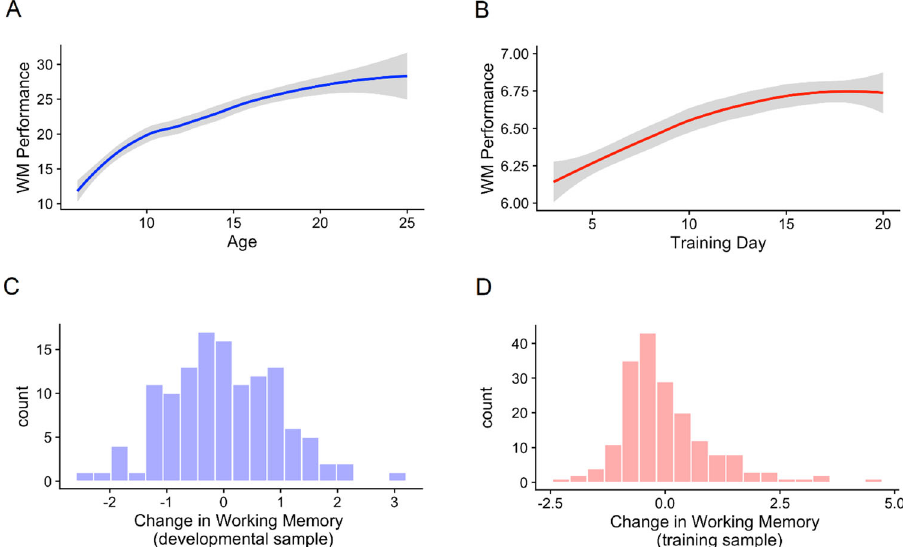
Fig. 1 WM performance at different time points and the variability of WM change between individuals. A Baseline WM performance in the different age groups from the developmental sample. That variable is a combination of visuospatial and verbal working memory tasks and is total the number of correct trials given at the start of the study and averaged between the two tasks. Shades represent standard error. B WM performance on different days during cognitive training in the training sample. This daily WM performance is a combination of visuospatial and a verbal working memory tasks and represents the average level of the three successful trials with the highest level on each day and averaged between the two tasks. Shades represent the standard error of the mean. C , D Distribution of standardized change in WM per count of individuals in the developmental sample (after 2 years) and the training sample, respectively. The WM change variable is the subtracted baseline WM from the follow-up WM in each sample and then separately standardized (mean of zero and standard deviation of 1). Values of zero represent the mean change in each